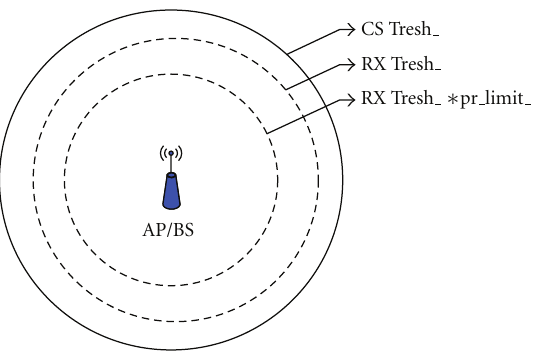
Figure 5: Power boundaries defined in